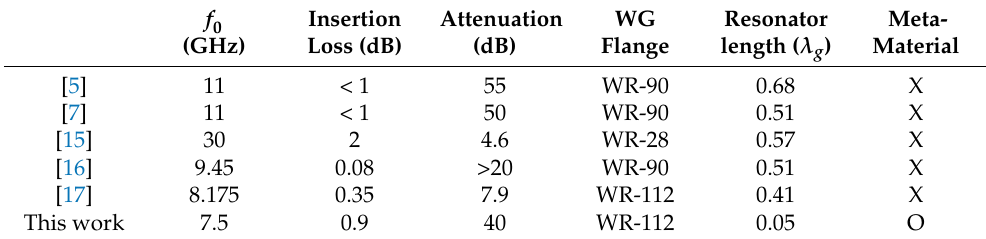
Table 8. Comparing the characteristics of the proposed filter and others’ filters.